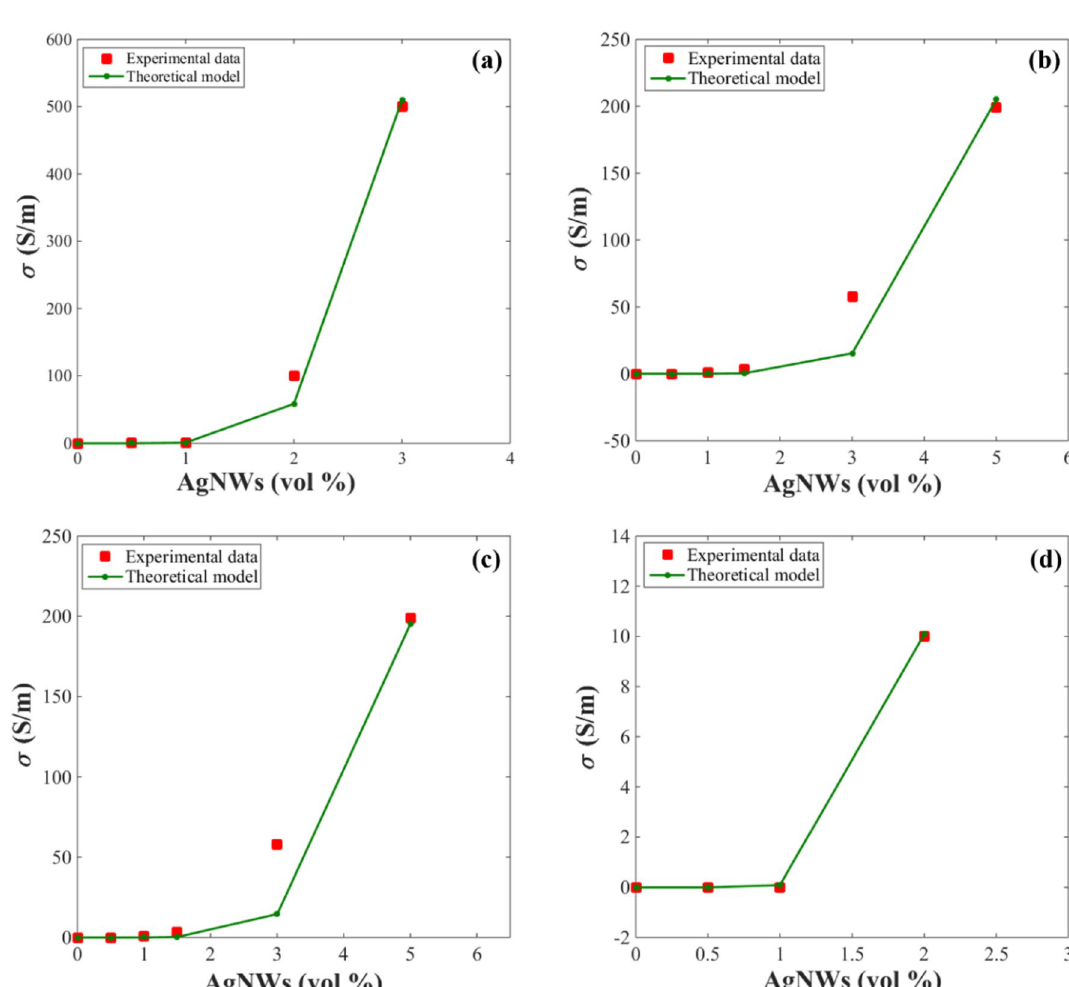
Figure 2. Experimental and theoretical conductivities for ( a ) PI/AgNWs 42 , ( b ) PEKK/AgNWs 43 , ( c ) PLA/ AgNWs 23 , and ( d ) PMMA/AgNWs 44 samples at different nanofiller concentrations based on the proposed